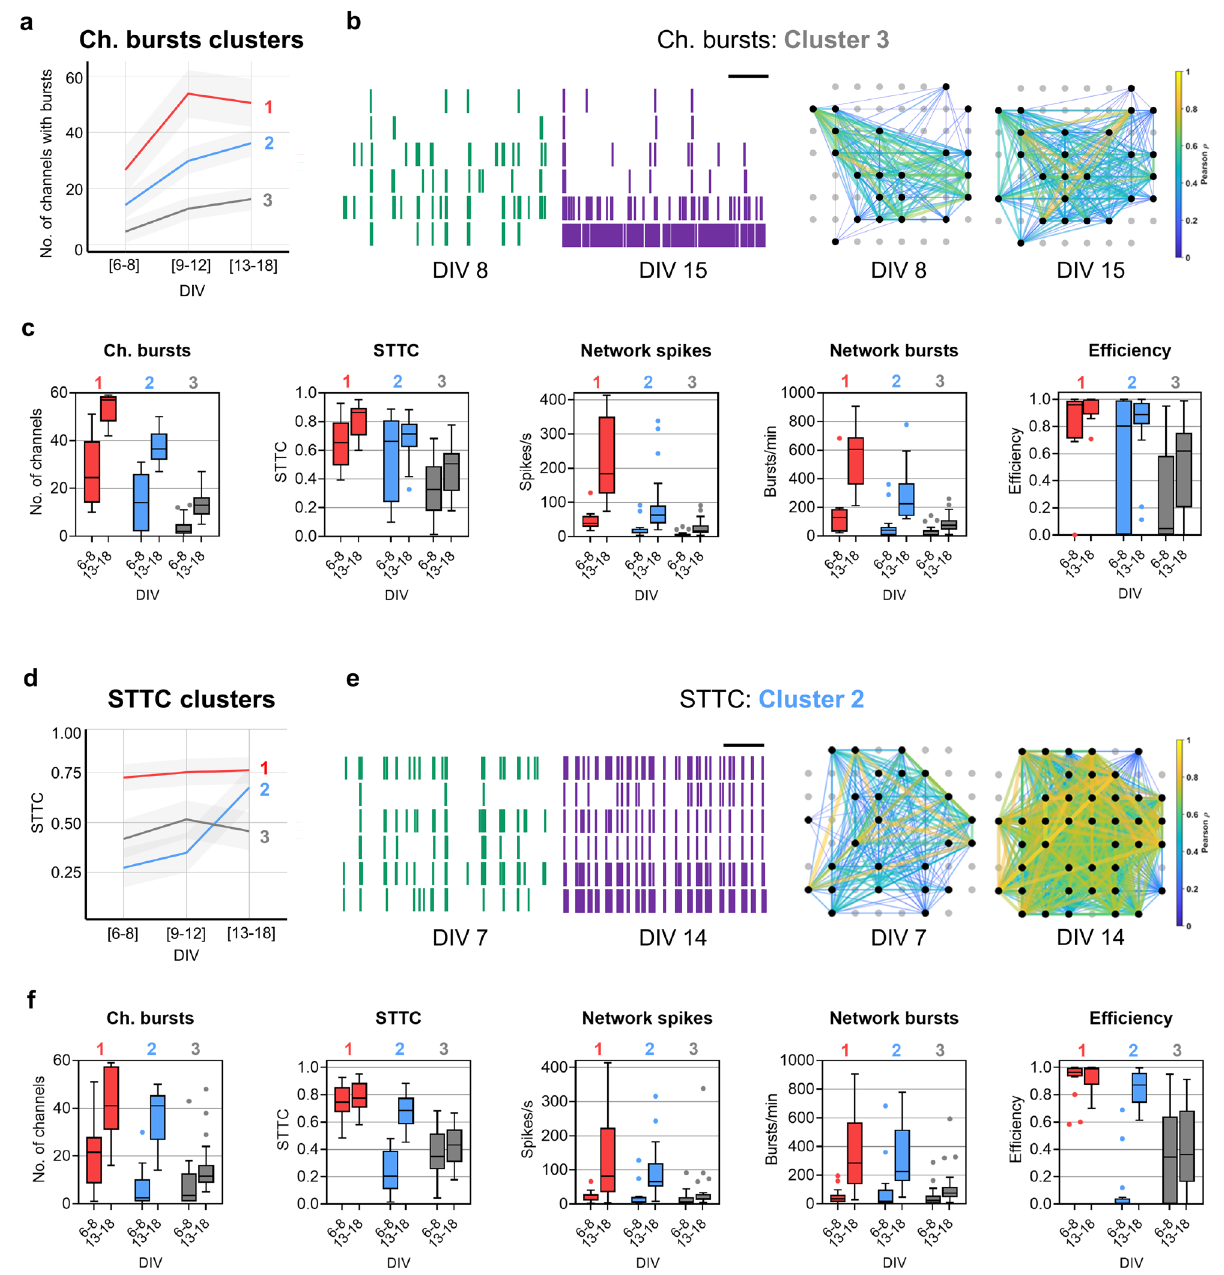
Figure 4. Patterns of developing spontaneous activity in neuronal networks using clustering analysis. ( a , d ) Graphs display three developmental patterns for the features of Ch. bursts ( a ) and STTC identified by k-means clustering of the SOM. The lines represent the means of the observations, labelled by k-means, and the shaded areas represent the 95% confidence intervals. ( b , e ) Examples of raster plots (left panels) and connectivity maps (right panels) of neuronal networks included in either cluster 3 of Ch. bursts ( b ) or cluster 2 of STTC ( e ). Horizontal scale bar in raster plots, 20 s. Color of the edges between nodes in connectivity maps represents Pearson’s correlation. ( c , f ) Changes in Ch. bursts, STTC, Network spikes, Network bursts, and Efficiency between DIV 6–8 and 13–18 in each cluster of Ch. bursts ( c ) and STTC ( f ). The box plots show the median and the interquartile range with Tukey whiskers. Clusters are indicated on top of the graphs. The figure was created using Graphpad 8.0 (https:// www. graph pad. com) ( c , f ), Neuroexplorer 5 (https:// plexon. com/ produ cts/ neuro explo rer/), Matlab 9.8 (https:// www. mathw orks. com/ produ cts/ matlab. html) ( b , e ), and R 4.03 (https:// www.r- proje ct. org/) ( a , d